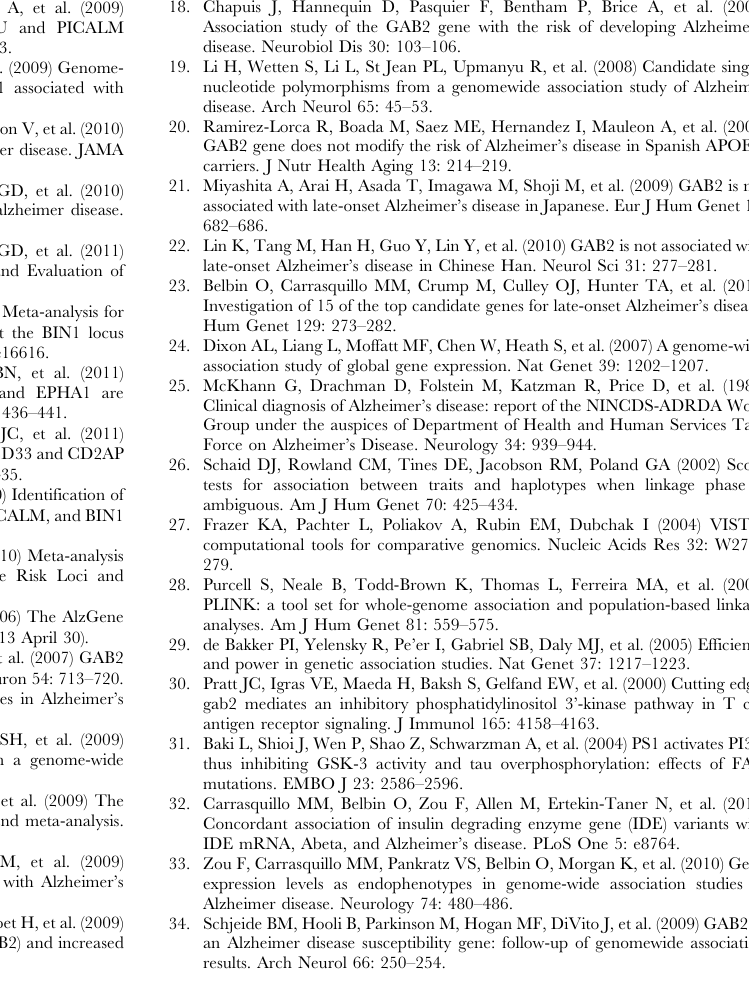
Table S1 Genotype, allele counts and allele frequencies for the eight GAB2 variants. Table S2 Pair-wise epistatic interaction tests between variants in GAB2 , APOE , BIN1 , CLU , CR1 and PICALM .